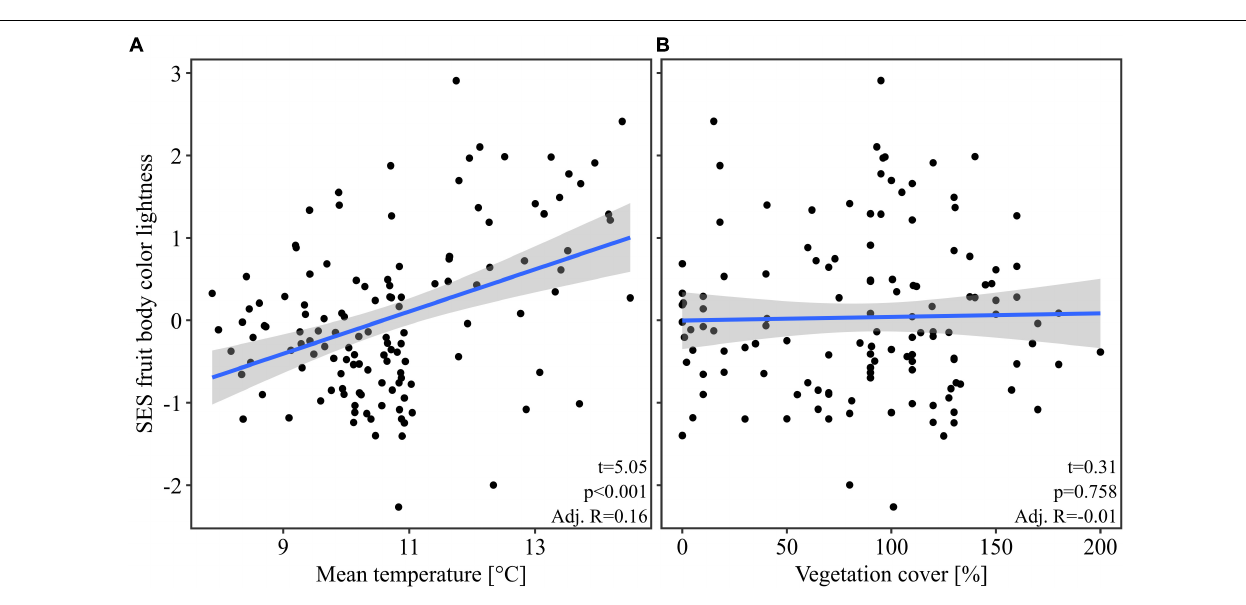
FIGURE 3 | Response of the standardized effect size of the assemblage fruit body color lightness. Here we used the null model “independentswap.” Response of the standardized effect size (SES) of the assemblage mean fruit body color lightness (A) to the mean temperature, and (B) to the vegetation cover per plot. The blue line indicates the univariate linear regression line with the standard error of the mean (shaded area). For multivariate statistics see Table 1